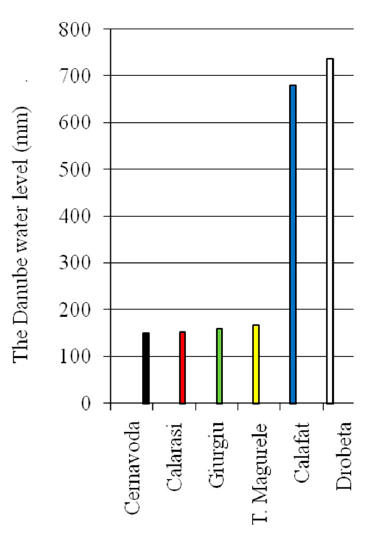
Figure 2. The Danube water levels in the cities that have been crossed during the period under discussion.